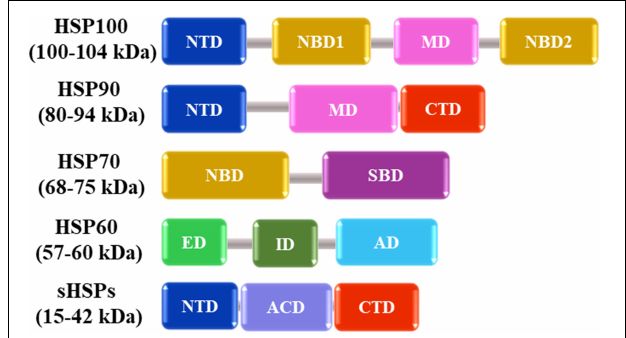
FIGURE 2 | Schematic representation of available domains in the five major families of heat shock proteins. NTD (N-terminal domain), NBD (Nucleotide binding domain), MD (Middle domain), CTD (C-terminal domain), SBD (Substrate binding domain), ED (Equatorial domain), ID (Intermediate domain), AD (Apical domain), and ACD (Alpha-crystallin domain) are shown as boxes with different colors based on their functions. Numbers in parenthesis indicate the molecular weight distribution of each HSP